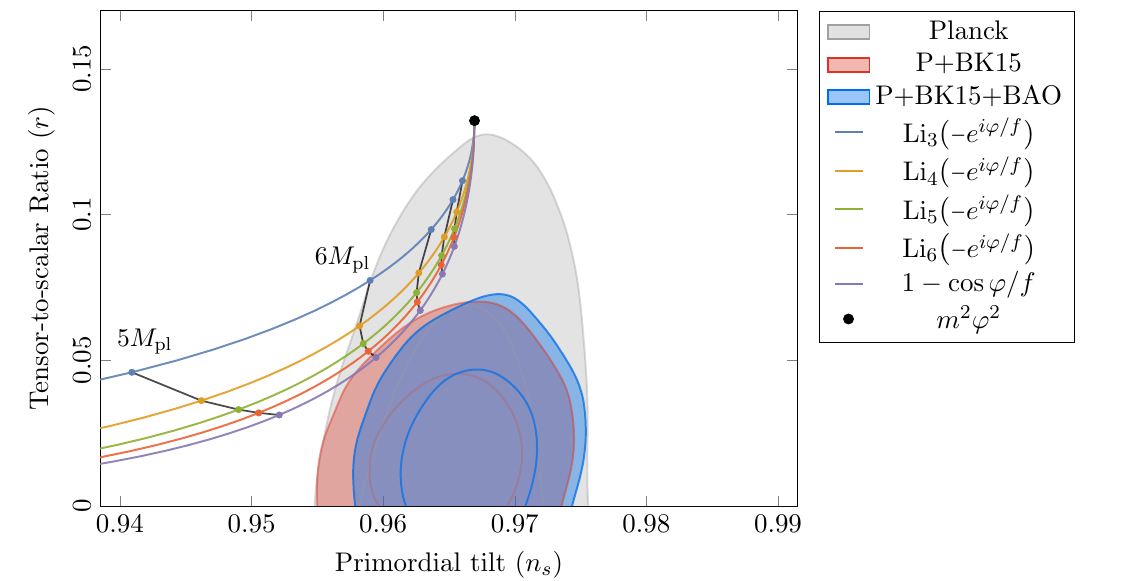
Figure 9. Predicted values of the spectral index n s and the tensor-to-scalar ratio r for the potential (4.5) with t ∗ = 0 and various values of α , natural inflation, and m 2 ϕ 2 at a pivot scale N ∗ = 60 , compared with the Planck 2018 1 σ and 2 σ exclusion limits. The predictions change as we vary the decay constant f and we mark each curve at f/M pl = 5 , 6 , . . . , 9 , connecting each set with a black line. As f → ∞ , all predictions approach that of m 2 ϕ 2 inflation. Similarly, the predictions from (4.5) replicate those of natural inflation when α (cid:29) 1